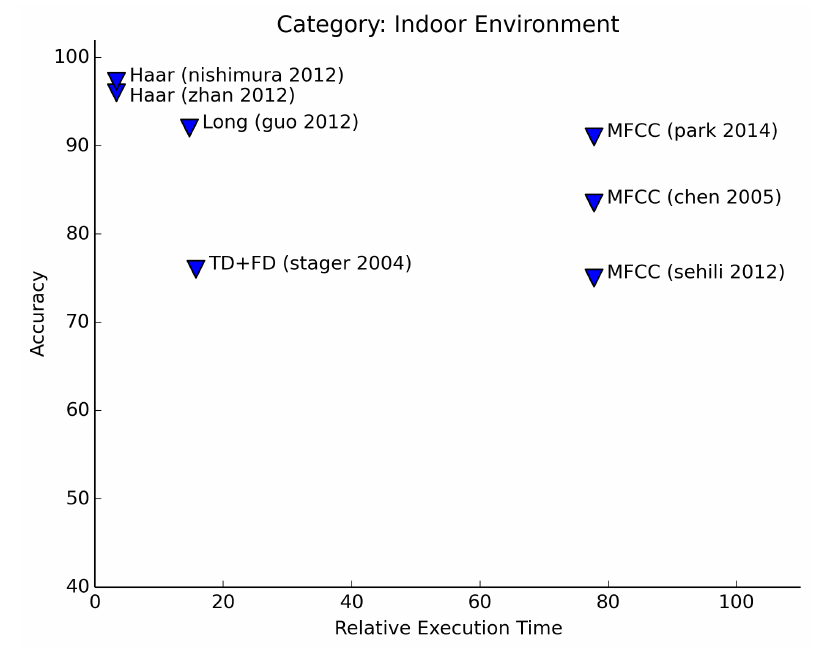
Figure 11. Relative execution time for indoor environment recognition.